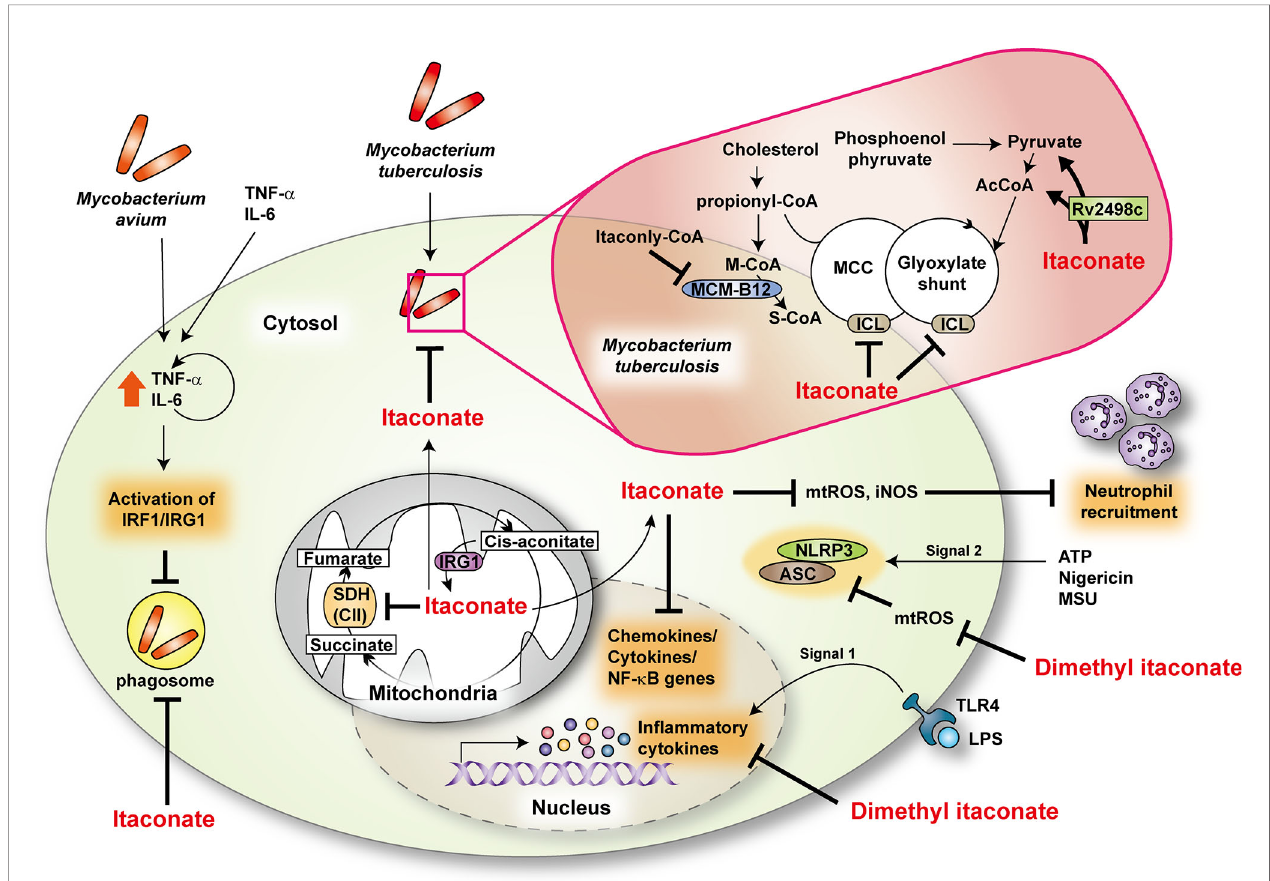
FIGURE 1 | The role of itaconate during mycobacterial infection. Itaconate, produced by immunoresponsive gene 1 (IRG1) from cis -aconitate, modulates TCA cycle by regulating succinate dehydrogenase (SDH, as complex II) activity. Dimethyl itaconate regulates the mRNA expression of in fl ammatory cytokines in response to LPS. In addition, dimethyl itaconate inhibits SDH and decreases the production of mitochondrial ROS (mtROS) in LPS-treated macrophages. It suppresses the expression of NLRP3 and ASC in NLRP3-activating conditions. During Mtb infection, IRG1 and itaconate downregulate in fl ammatory responses at the transcriptional level and neutrophil recruitment through inhibiting the production of mtROS and inducible nitric oxide synthase (iNOS). In Mtb, itaconate has an antimicrobial activity for methyl citrate lyase (MCL) in the methyl citrate cycle (MCC) and isocitrate lyase (ICL) in glyoxylate shunt, enzymes that are needed for Mtb survival. Moreover, itaconyl-coenzyme A (CoA) targets B 12 -dependent methylmalonyl-CoA mutase (MCM-B12) to restrict bacterial growth. Mtb effector Rv2498c participates in itaconate dissimilation to confer resistance to itaconate. During M.avium infection, tumor necrosis factor- a (TNF- a ) and interleukin (IL)-6 activate interferon regulatory factor 1 (IRF1)/IRG1 through the autocrine/paracrine signaling pathway. AcCoA, acetyl-coenzyme A; ASC, apoptosis-associated speck-like protein containing a CARD; ATP, adenosine triphosphate; LPS, lipopolysaccharide; M-CoA, methylmalonyl-coenzyme A; MSU, monosodium urate; NLRP3, NLR family pyrin domain containing 3; S- CoA, succinyl-coenzyme A; TLR4, toll-like receptor